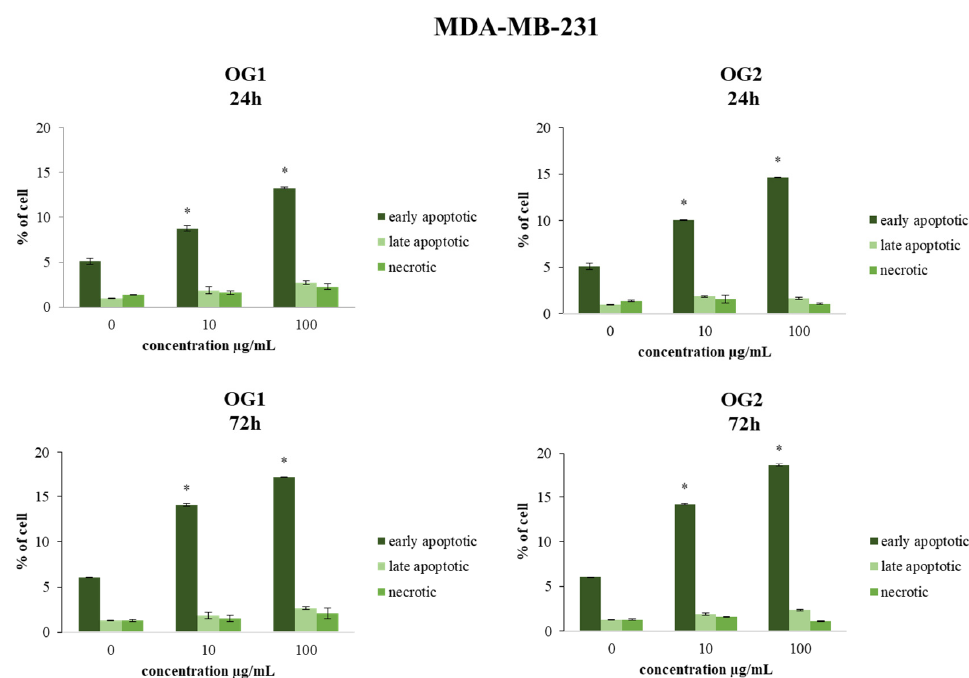
Figure 4. Flow cytometric analysis of Annexin V-FITC/7-AAD stained MDA-MB-231 cells for 24 h and 72 h exposure with essential oils OG1 and OG2 at concentrations 10 µ g/mL and 100 µ g/mL. The percentages of early apoptotic (Annexin V+7-AAD − , lower right quadrant), late apoptotic (Annexin V+7-AAD+, upper right quadrant) and necrotic cells (AnnexinV7-AAD+, upper left quadrant) in nontreated and treated cells are indicated on dot plots. Results are presented as the mean of three independent experiments ± standard error; * p < 0.05 relative to control.